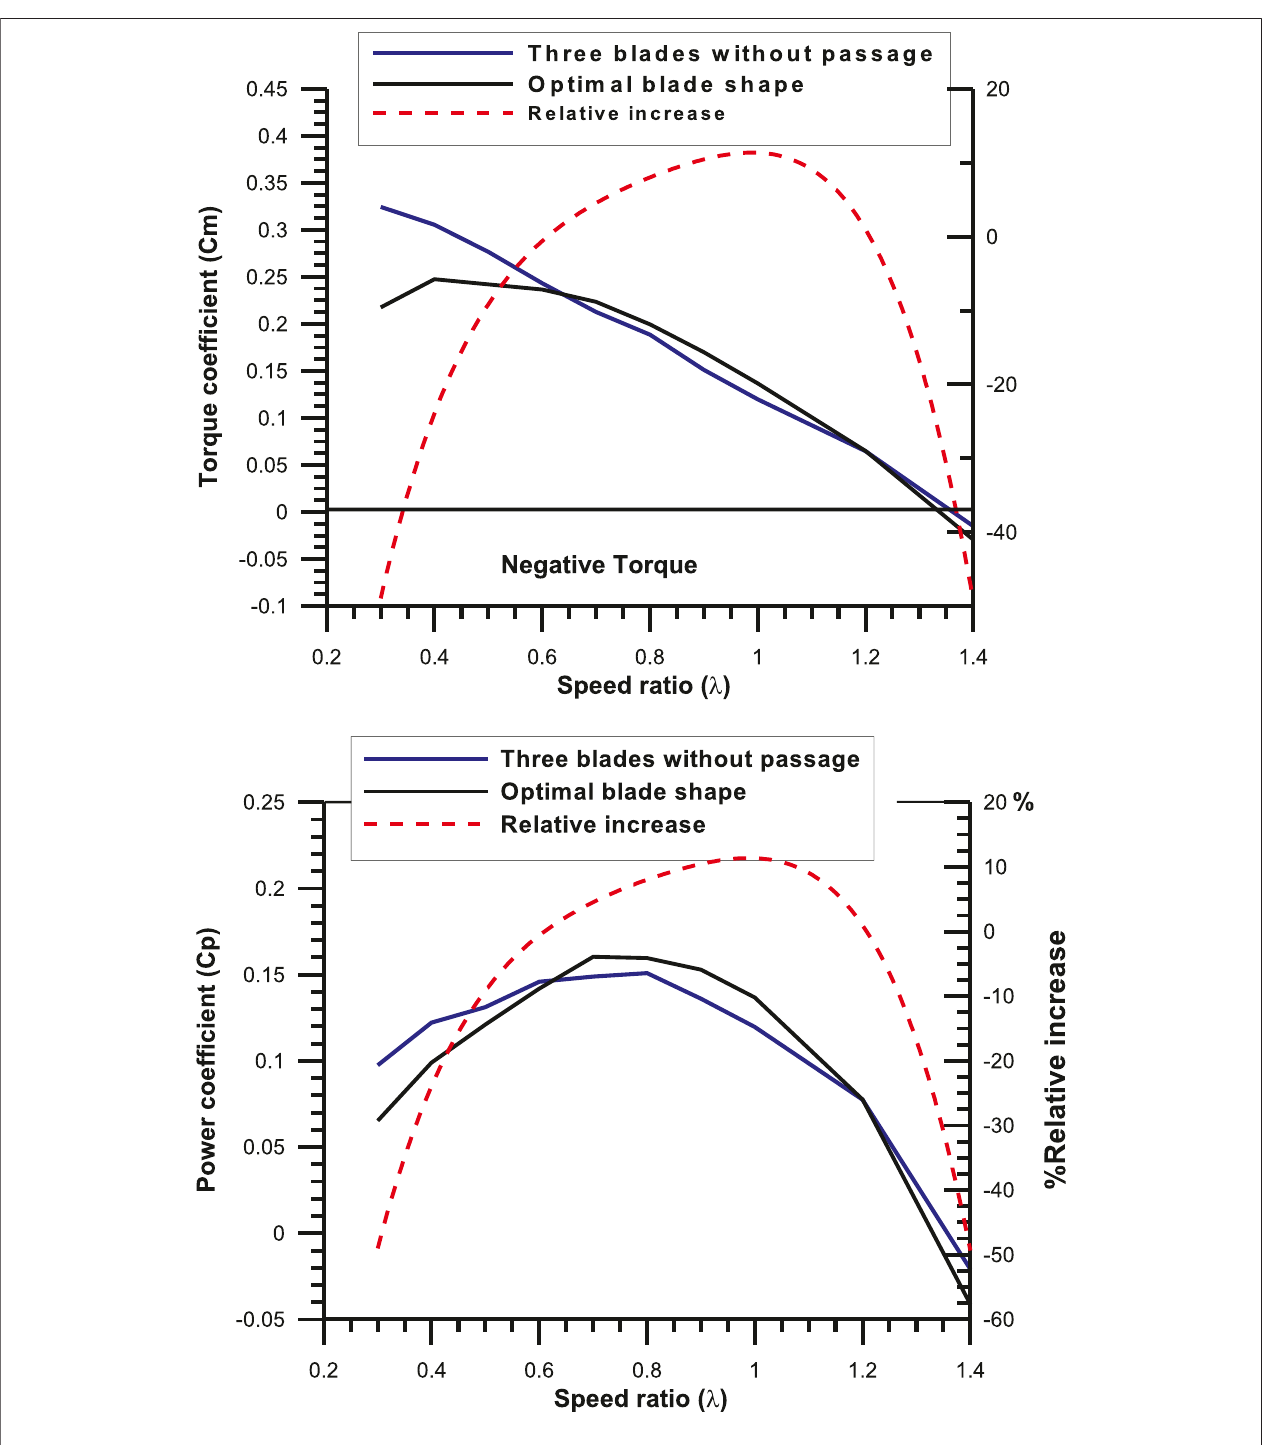
FIGURE 8 | Power coef fi cient of the optimized con fi guration compared to the modi fi ed turbine.